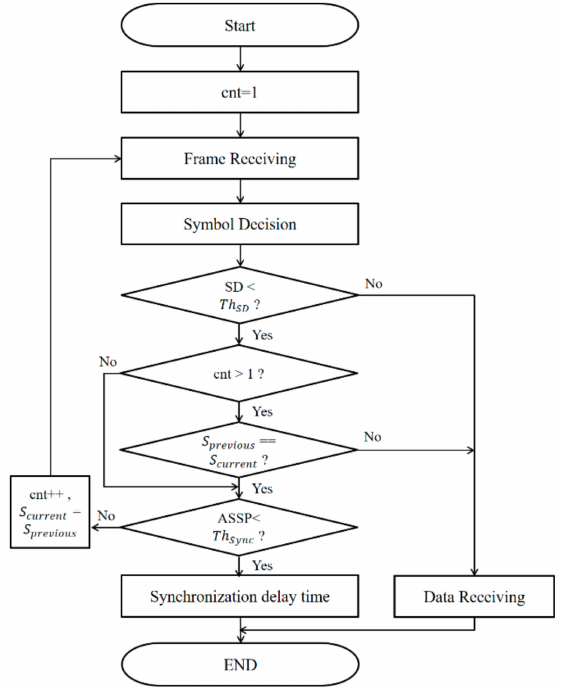
Figure 11. Synchronization flow chart for a color-independent visual-MIMO system on the receiver side